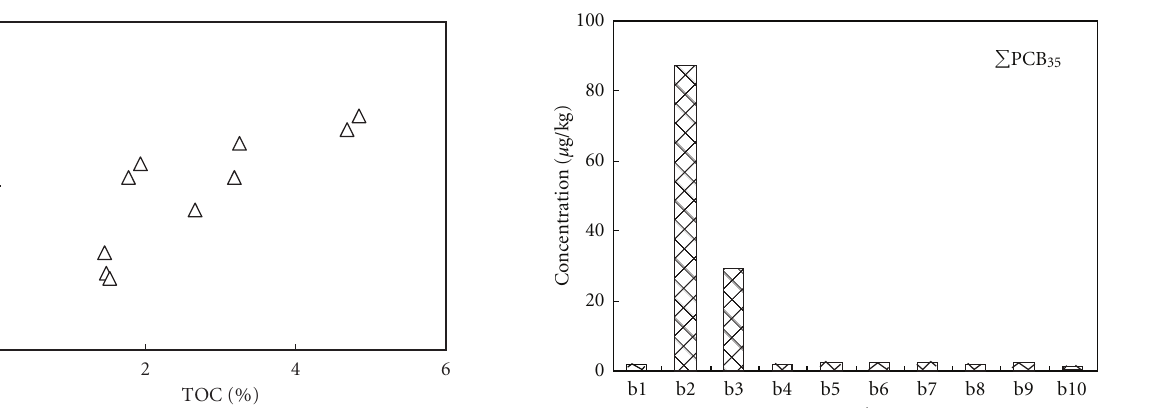
F 4: Concentrations of total PCBs in the studied sediments.